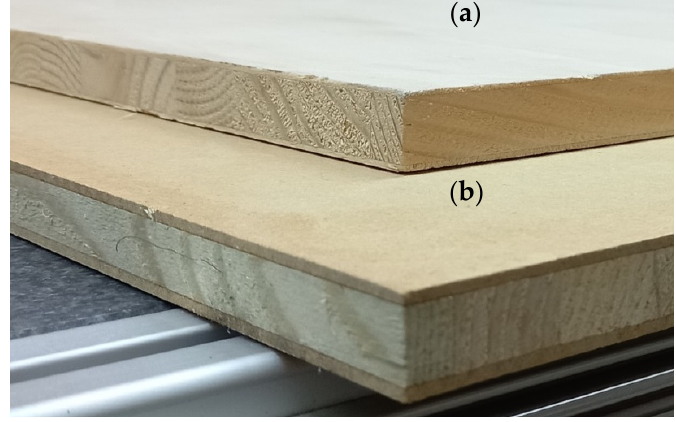
Figure 1. Blockboard structure: ( a ) panel with veneer (V) face sheets; ( b ) panel with HDF face sheets.